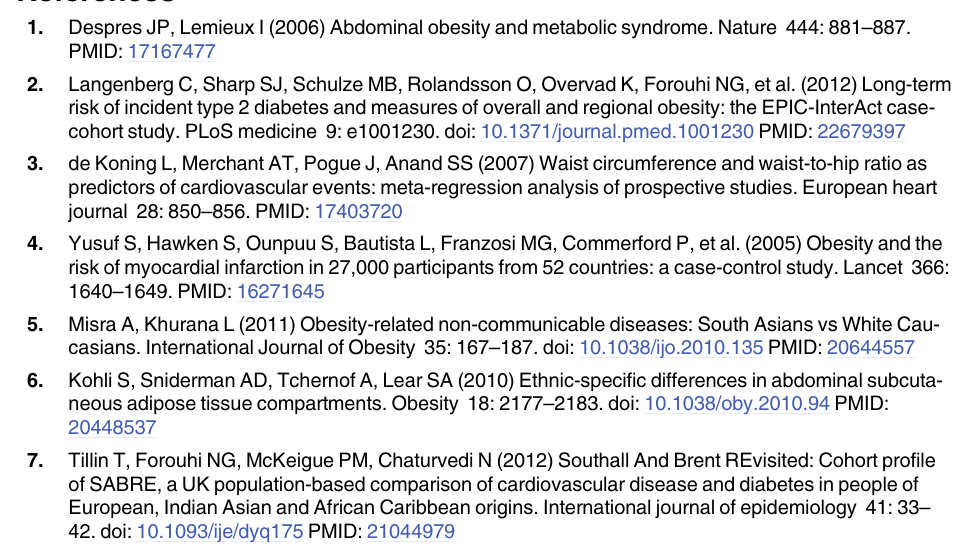
S7 Table. South Asian exome-array analysis – Top ranking gene-based association results at P < 1x10 -3 . S8 Table. Comparison of 48 known WHR SNPs in South Asians (N = 12,240; extended analysis) and